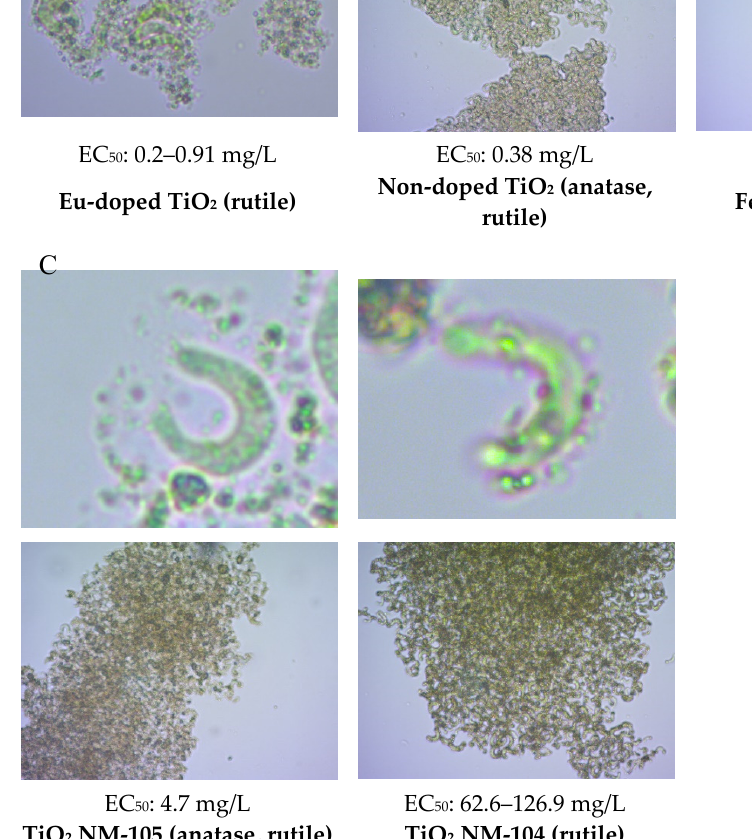
Figure 7. Comparative analysis of the EC 50 values and attachment behavior of three CeO 2 ENMs ( A ) and five TiO 2 ENMs ( B , C ) (magnification 100× and 1000×).